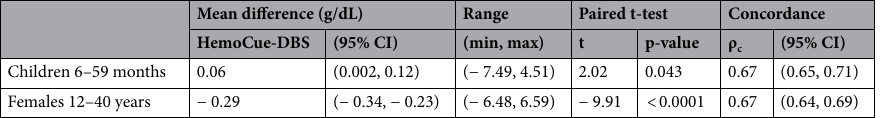
Table 3. Measures of agreement between HemoCue and DBS, children 6–59 months and females 12–40 years. CI confidence